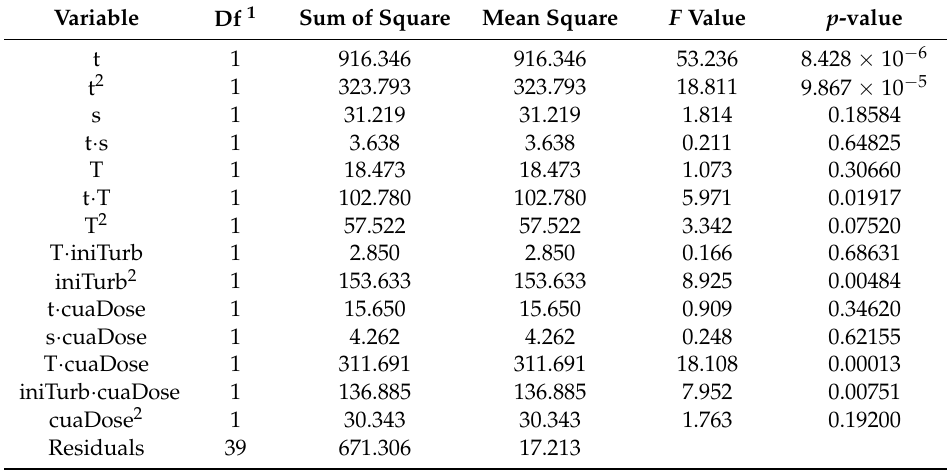
Table 5. ANOVA values for the “finTurb” quadratic model for ECOTAN BIO 90D.